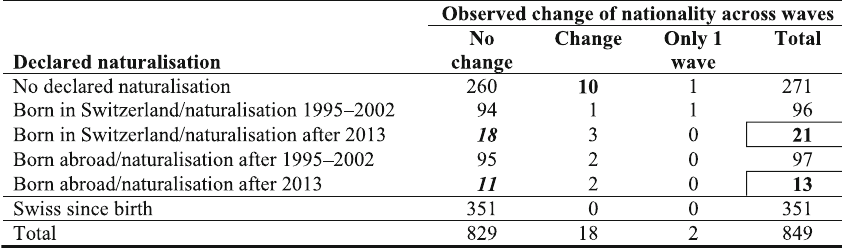
Table 4 Declared naturalisation and observed change of nationality across waves